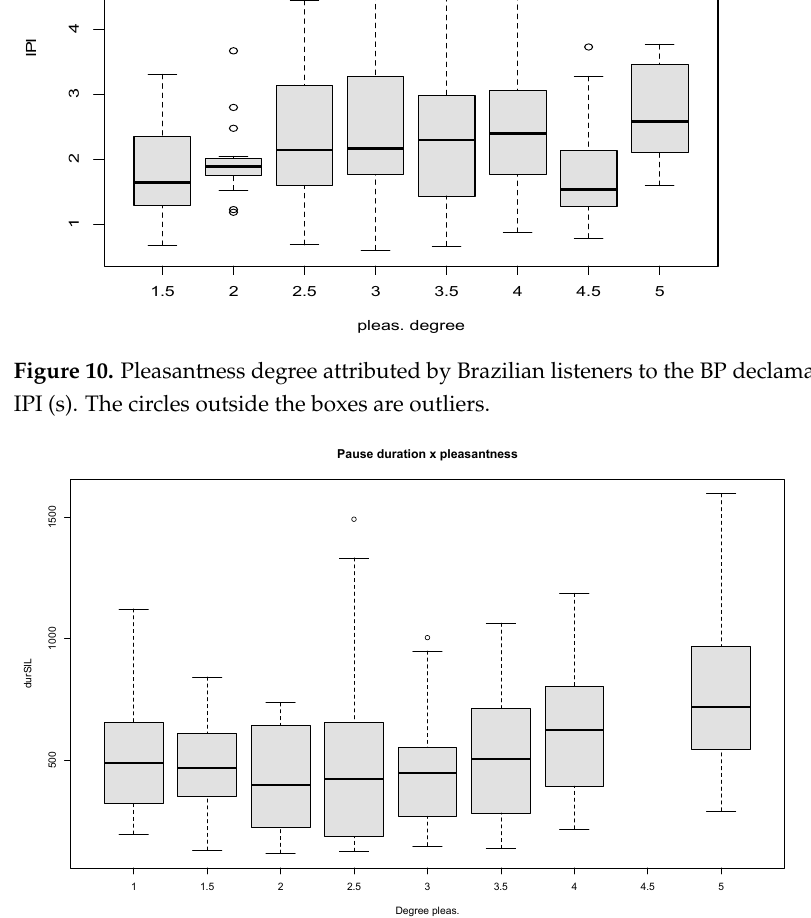
Figure 11. Pleasantness degree attributed by Portuguese listeners to the EP declamations, according to pause duration (ms). The circles outside the boxes are outliers.